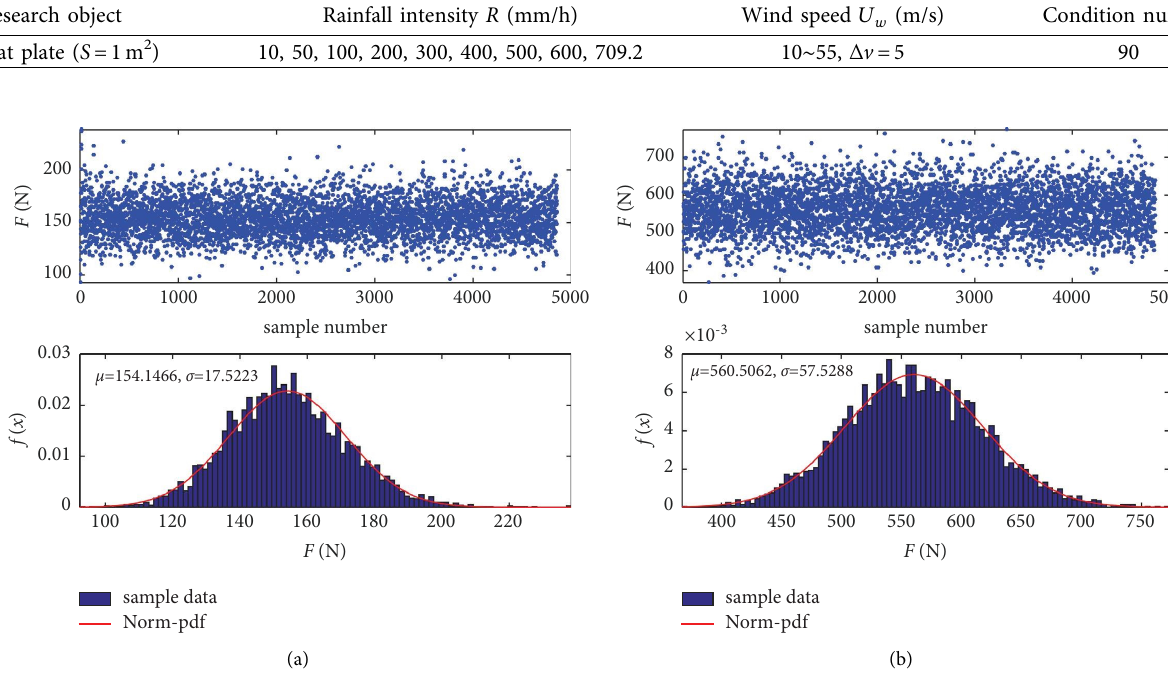
Figure 27: Statistical probability distribution of raindrop impact loads. (a) R � 709.2mm/h- v � 30m/s. (b) R � 709.2mm/h- v � 55